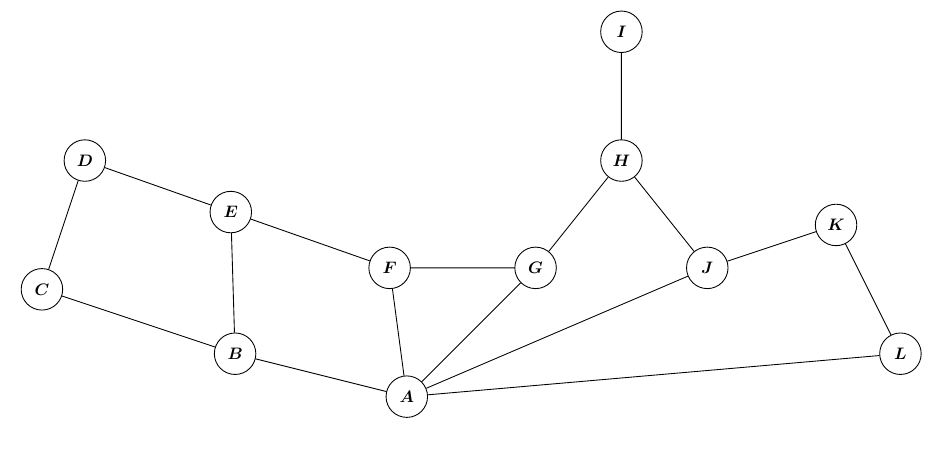
Fig. 3 Schematic representation of the network of the Example 6.2